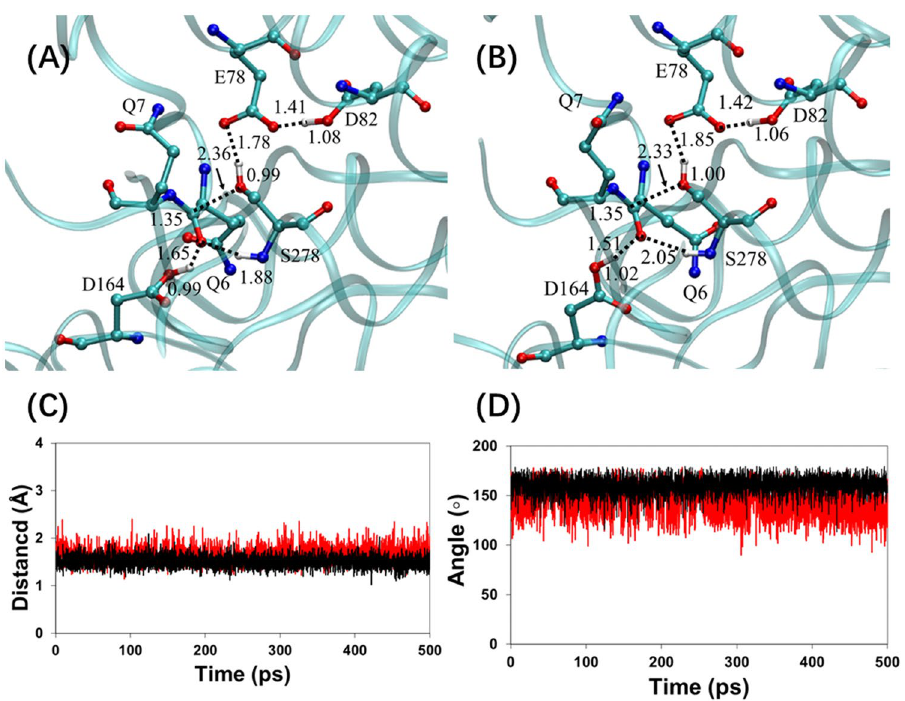
Figure 2. Reactant state (RS) complexes and distributions of distance and angle obtained by the QM/ MM(DFTB3/CHARMM36) MD simulation. ( A ) Average structure of kumamolisin-As RS complex generated by 500 ps QM/MM MD simulation. ( B ) Average structure of Kuma030 RS complex generated by 500 ps QM/ MM MD simulation. ( C ) Distance distribution of the hydrogen bond r(O S … H D ) during 500 ps MD simulation. ( D ) Distribution of the hydrogen bond angle a(O S … H D -O D ) during 500 ps MD Enzymes-PFPQPQQPF binding mode. The QM/MM(DFTB3/CHARMM36) MD simulations, in which the atoms included in QM region were described by the third-order self-consistent charge density functional tight-binding (DFTB3, 3ob-2-1) 26 method and the MM atoms were described by the classical CHARMM36 force field 27 , were performed to reveal the binding properties in the RS complexed formed by KumaWT and Kuma030 with the substrate (PFPQPQQPF). As shown in Fig. 2, average structures of active sites show a good interaction between substrates and the active sites of KumaWT and Kuma030. The important residues of KumaWT and Kuma030 consist of the catalytic triad (E78, D82, and S278) and residues forming the oxyanion hole. The oxyan- ion hole is constructed by the side chain of Asp164 and the amide groups of Ser278. The hydrogen bond networks were formed within the catalytic triad in both RS complexes. The hydrogen bond network is formed among the catalytic triad 16–18 . KumaWT and Kuma030 share the same patterns on the interactions between enzymes and substrates in the active sites, but the strength of the interactions is slightly different with each other. On one hand, the Ser278 O γ atoms of KumaWT and Kuma030 interact well with the P1-Gln6 C S of substrate (PFPQPQQPF). The corresponding interaction distances are 2.36 and 2.33 Å, respectively. Those distances make the O γ atoms of Ser278 in good position for nucleophilic attack toward the C S atoms of the substrates. On the other hand, the